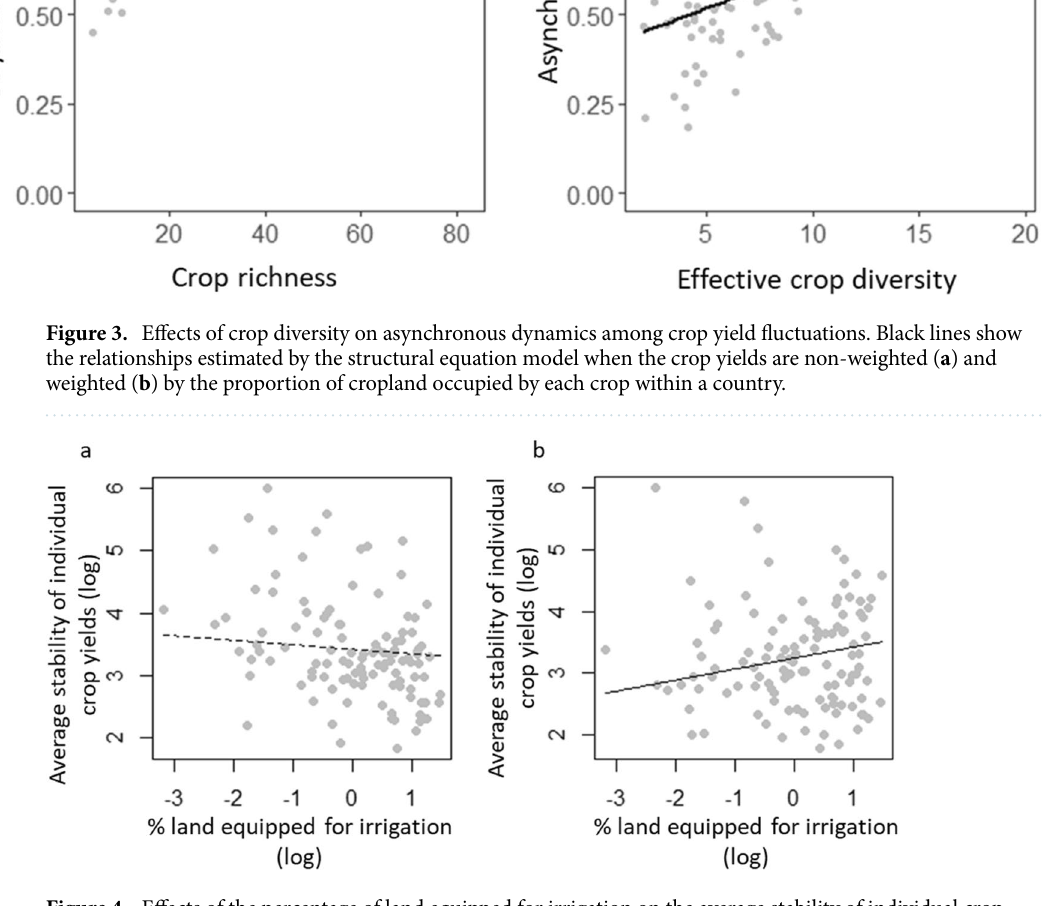
Figure 4. Effects of the percentage of land equipped for irrigation on the average stability of individual crop yields. Black lines show the relationships estimated by the structural equation model when the crop yields are non-weighted ( a ) and weighted ( b ) by the proportion of cropland occupied by each crop within a